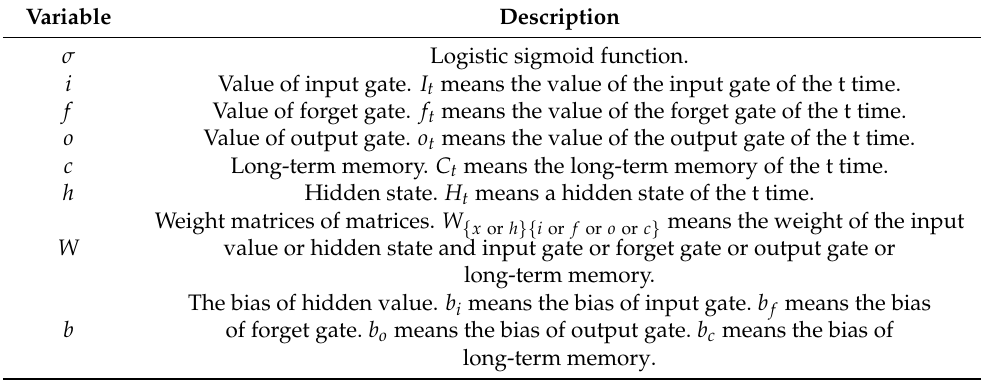
Table 5. Variables of the LSTM